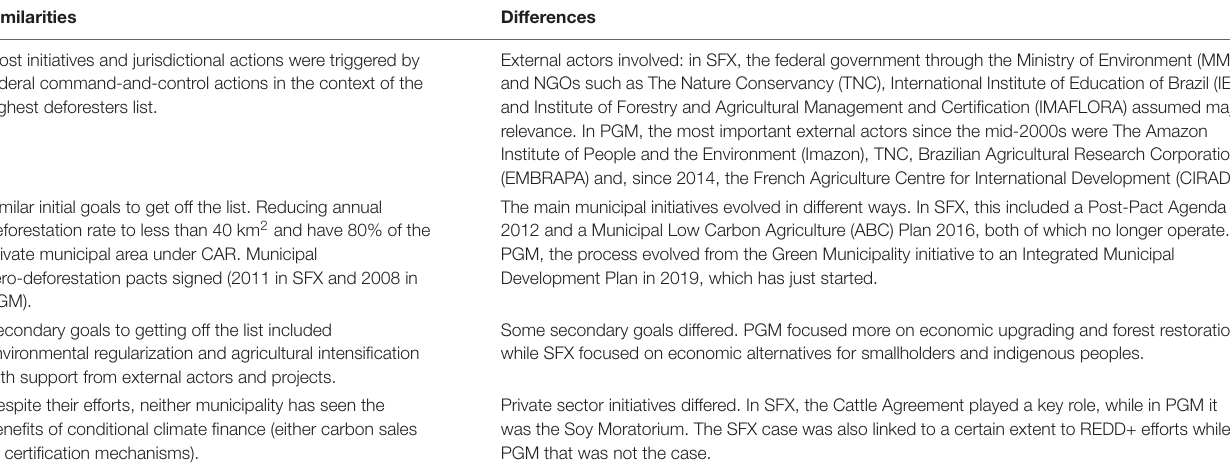
TABLE 3 | Similarities and differences between initiatives in Paragominas and São Félix do Xingu.